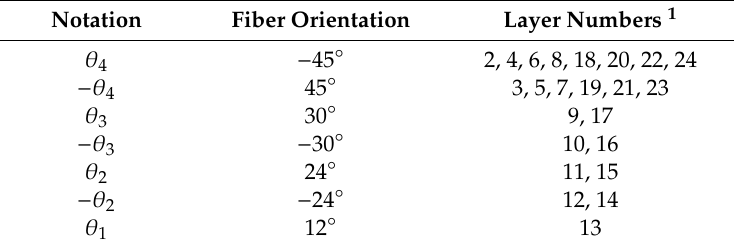
Figure 3. Schematic of 3D-printing sequence of multi-angled 3D-printed glass fiber reinforced polymer (GFRP) composites (Set 2). Table 2. 3D-printing sequence in the multi-angled 3D-printed glass fiber reinforced polymer (GFRP) composites (Set